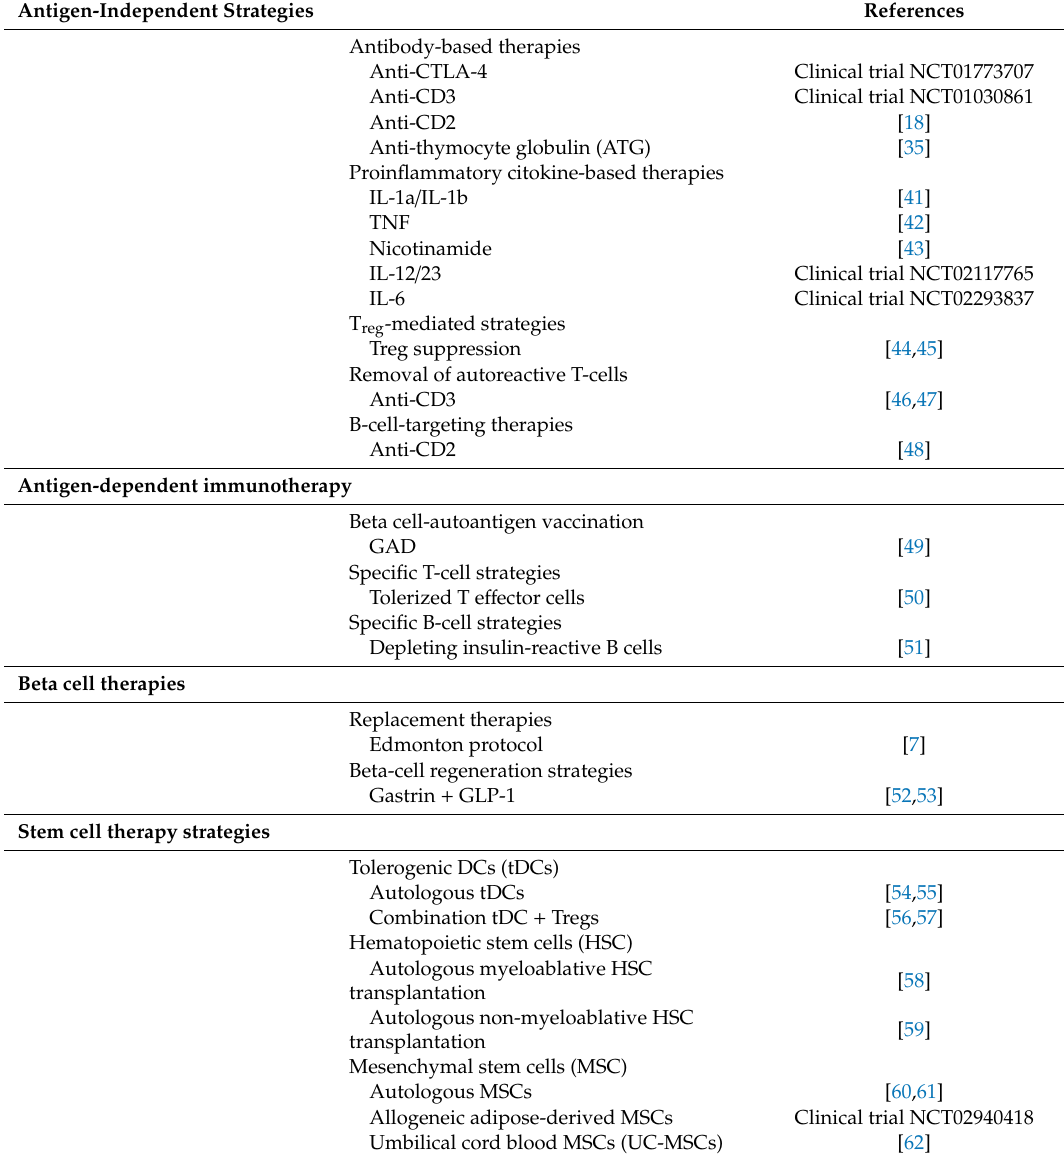
Table 2. Strategies for the treatment of